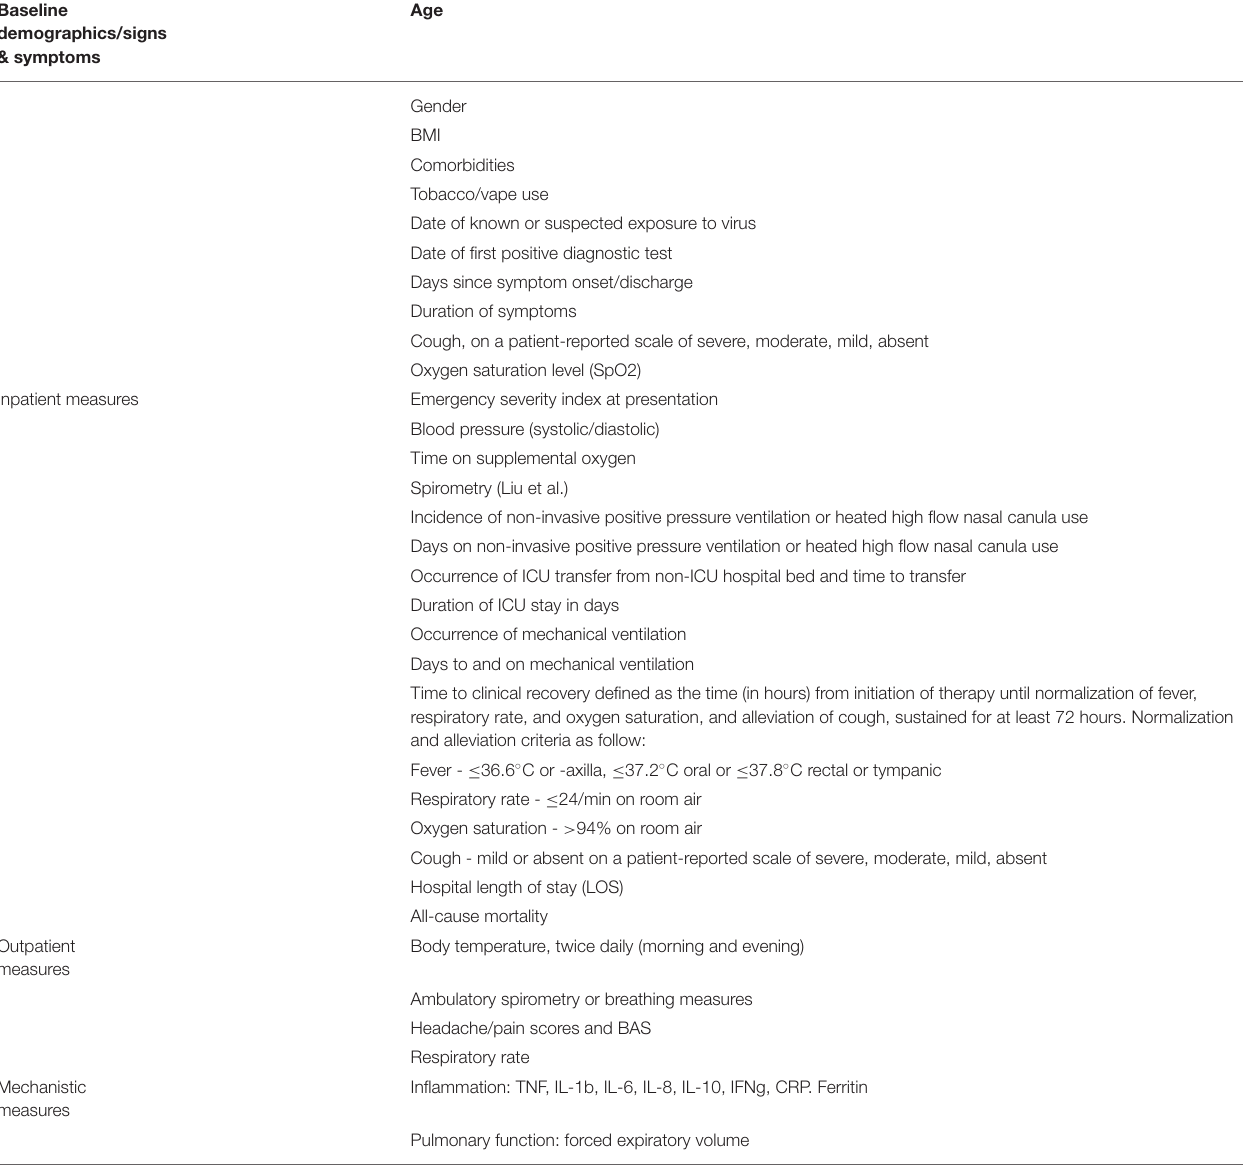
TABLE 6 | Recommended clinical trial endpoints for studies of neuromodulation technologies in COVID-19. Baseline